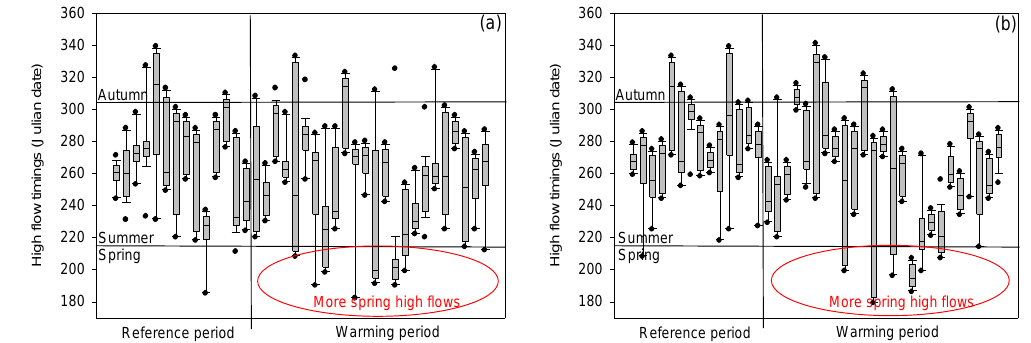
Figure 7. High flow timings for each year in the UHR ( a ) and GR ( b ) watersheds.